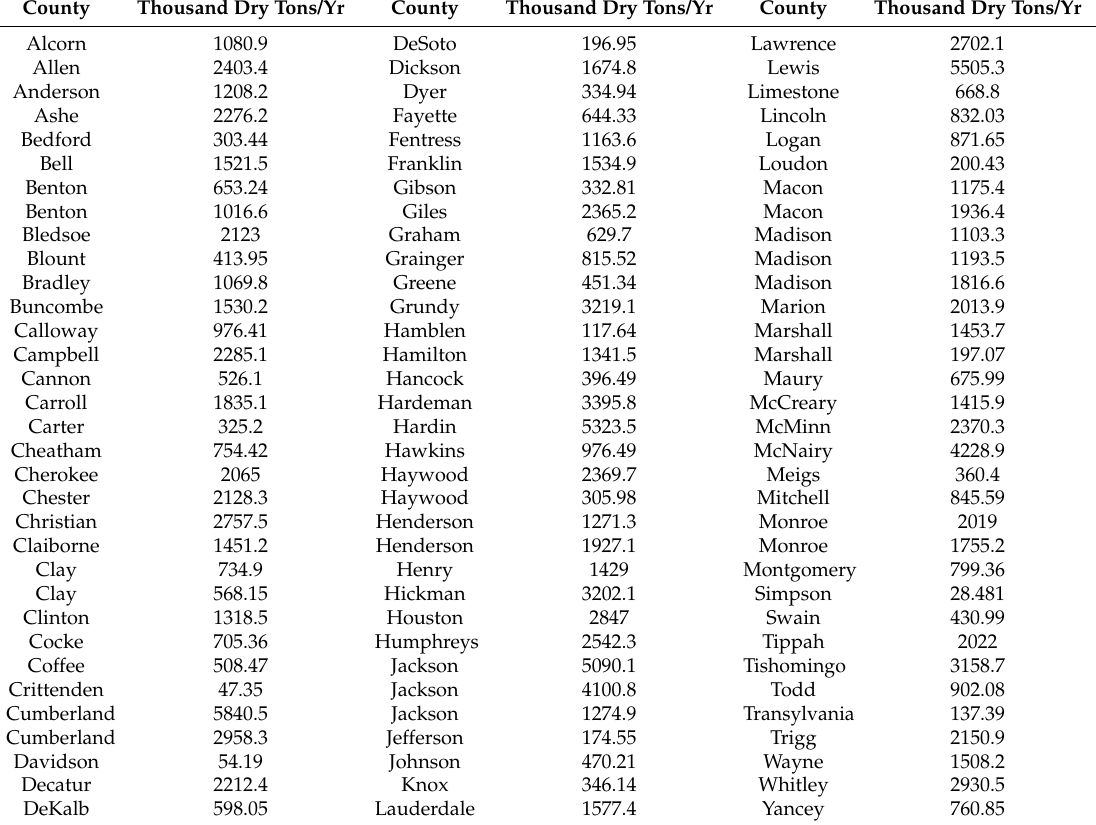
Table A2. List of counties included in the case